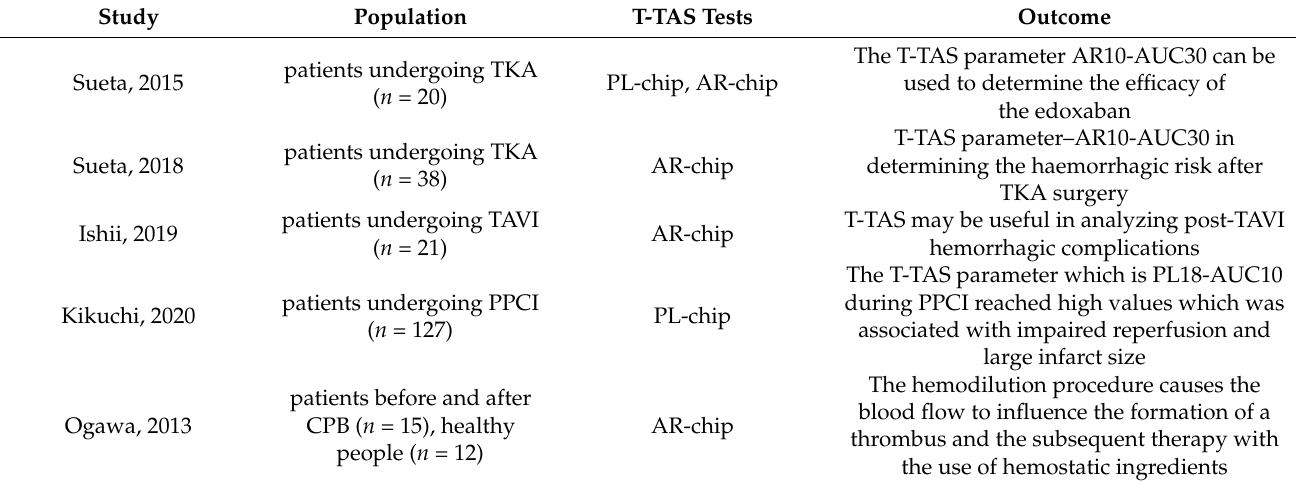
Table 4. Comparison of studies on the application of T-TAS in surgical procedures (AR10-AUC30—area under the flow pressure curve for the first 30 min for AR-chip tested at flow rate of 10 µ L/min, CPB—cardiopulmonary bypass, PL18- AUC10—area under the flow pressure curve for the first 10 min for PL-chip tested at flow rate of 18 µ L/min, PPCI—primary